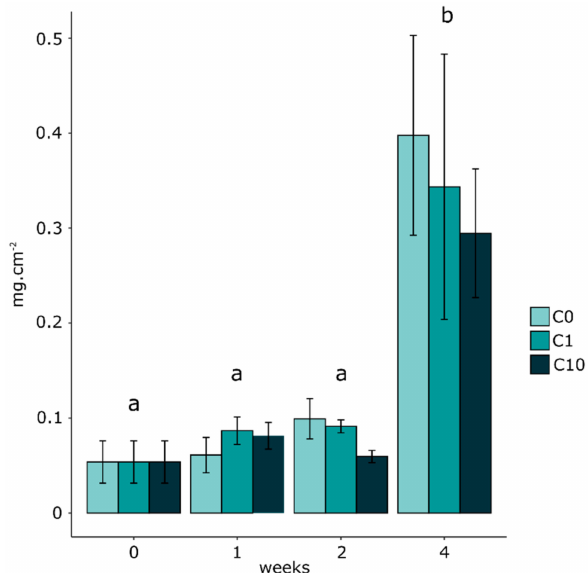
Figure 1. Biofilm biomasses over time in control (C0 = 0.2 ± 0.1 nM) and Zr exposures (C1 = 0.5 ± 0.3 nM and C10 = 2.9 ± 0.3 nM). Values are averages and standard errors. Two-way ANOVA was performed to detect significant di ff erences between exposure times, and these di ff erences are indicated by letters ( p < 0.05; n =